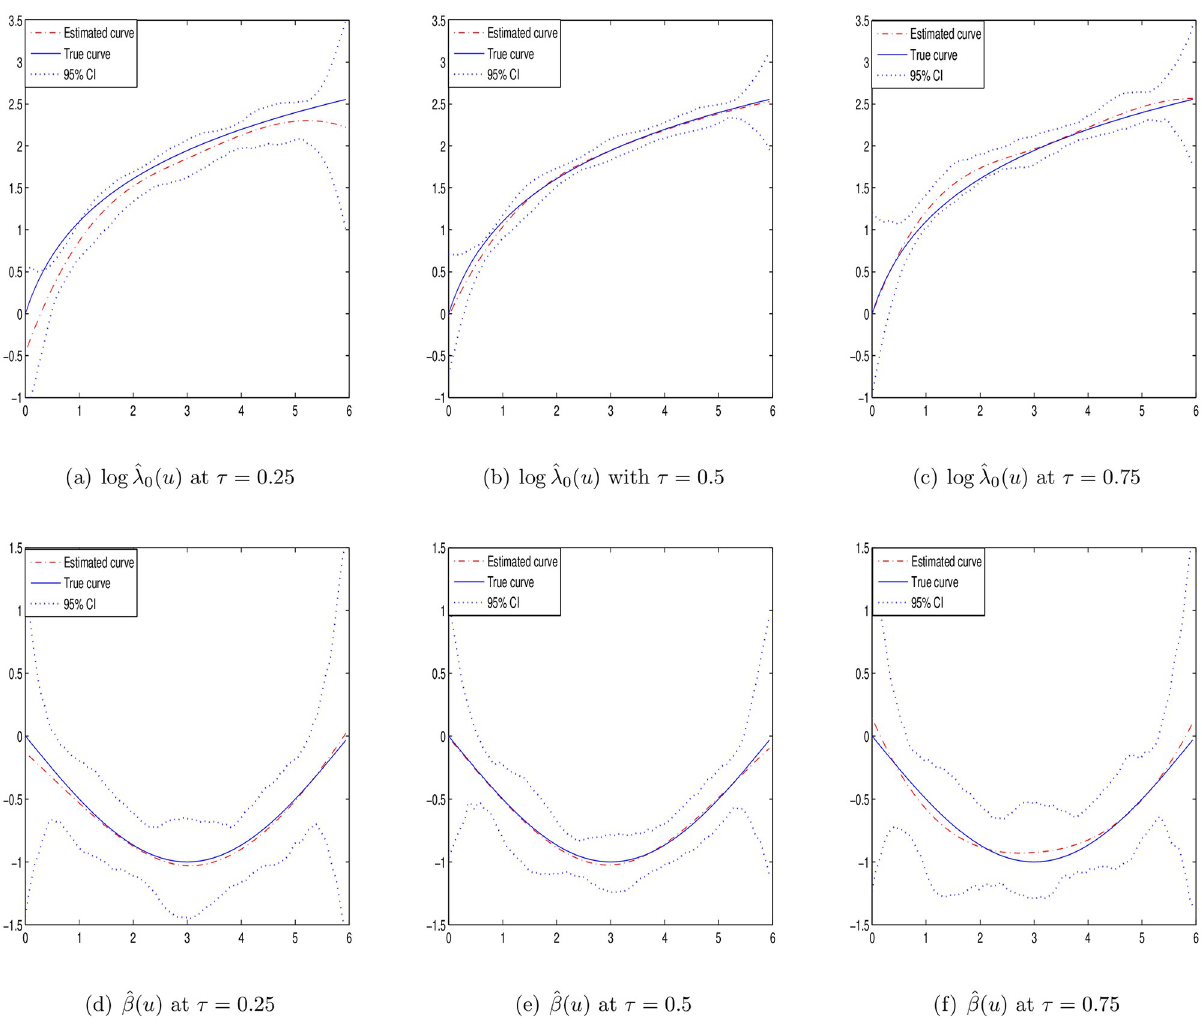
Fig 1. Estimated curves of time-varying functions in case I at different τ with n =